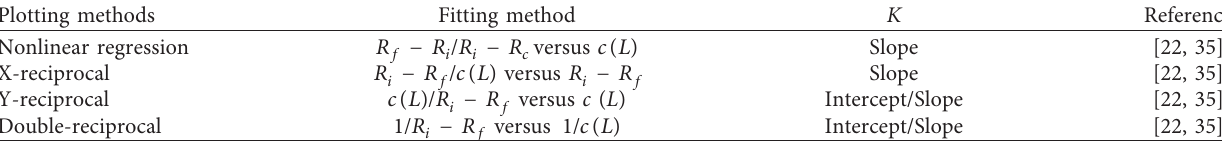
Table 3: Statistical components of four plotting methods used for the calculation of binding constant ( K ).